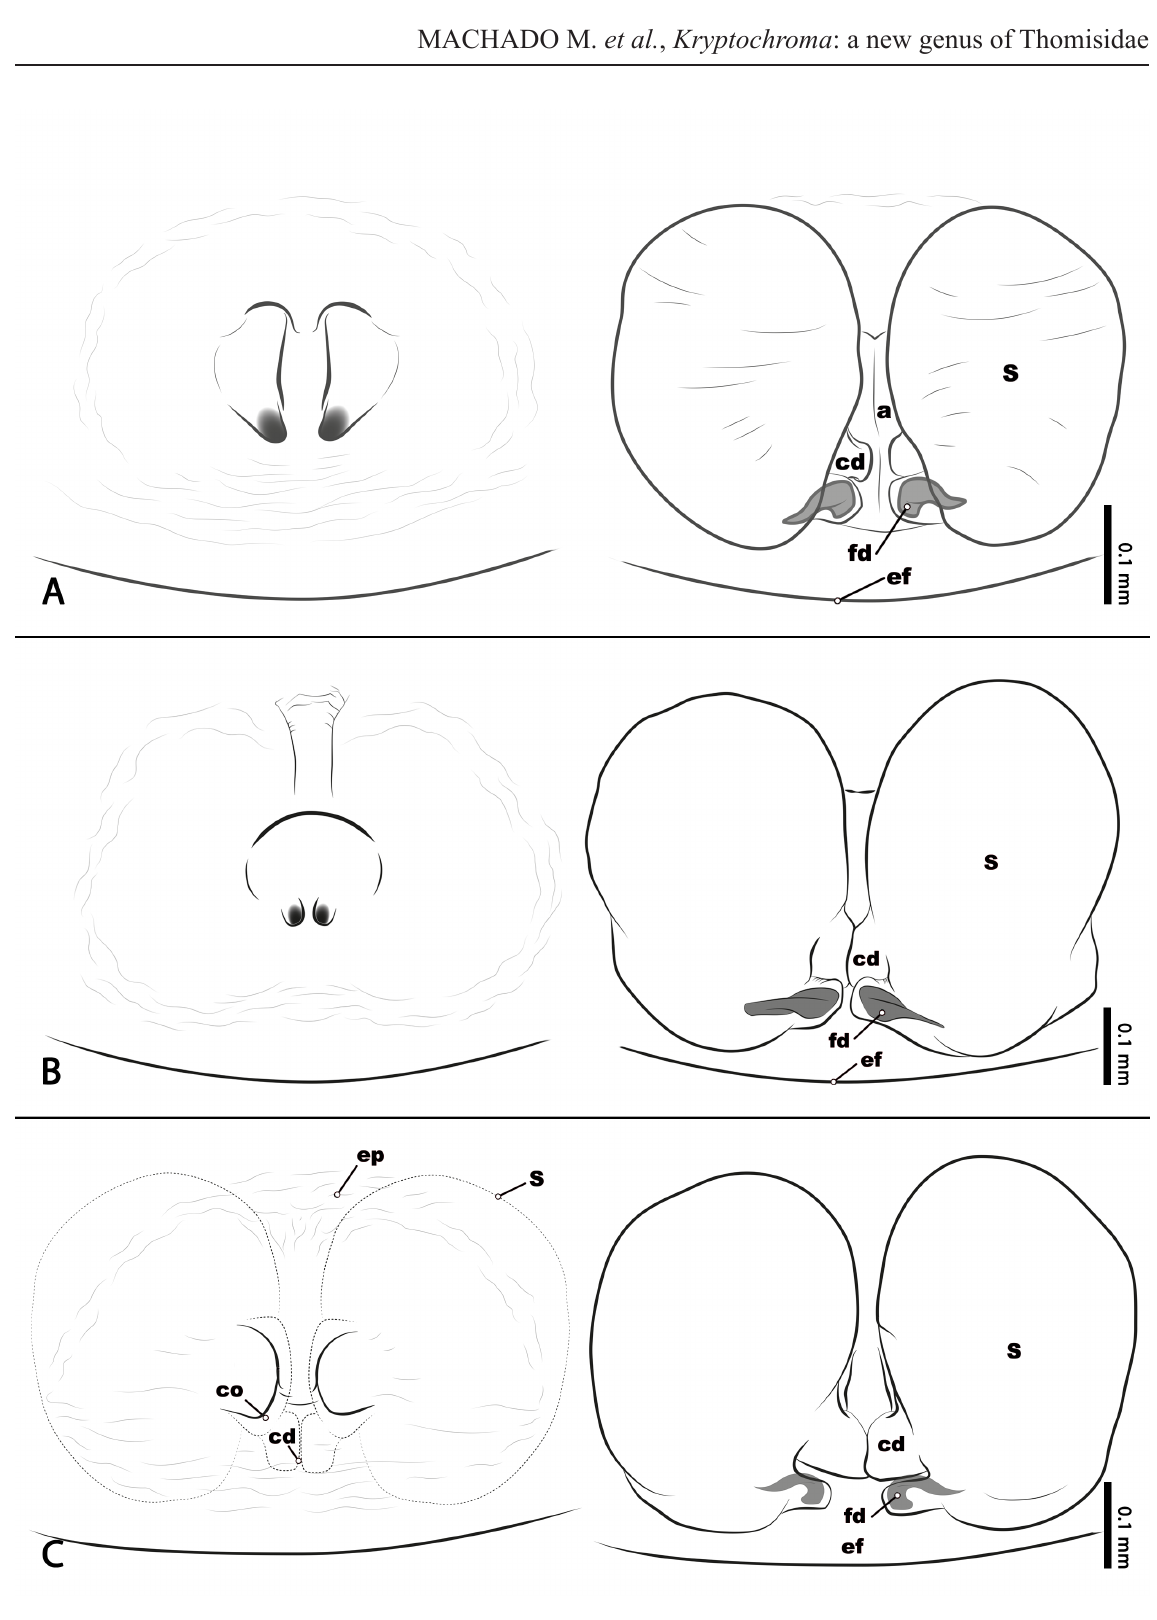
Fig. 22. Illustrations of epigynum in ventral and dorsal view. A . Kryptochroma pentacantha (Mello- Leitão, 1929) gen. et comb. nov. (MCTP 38671). B . K. quadrata Machado & Viecelli gen. et sp. nov., apratype (MPEG 13297). C . K. septata Machado & Teixeira gen. et sp. nov., holotype (UFMG